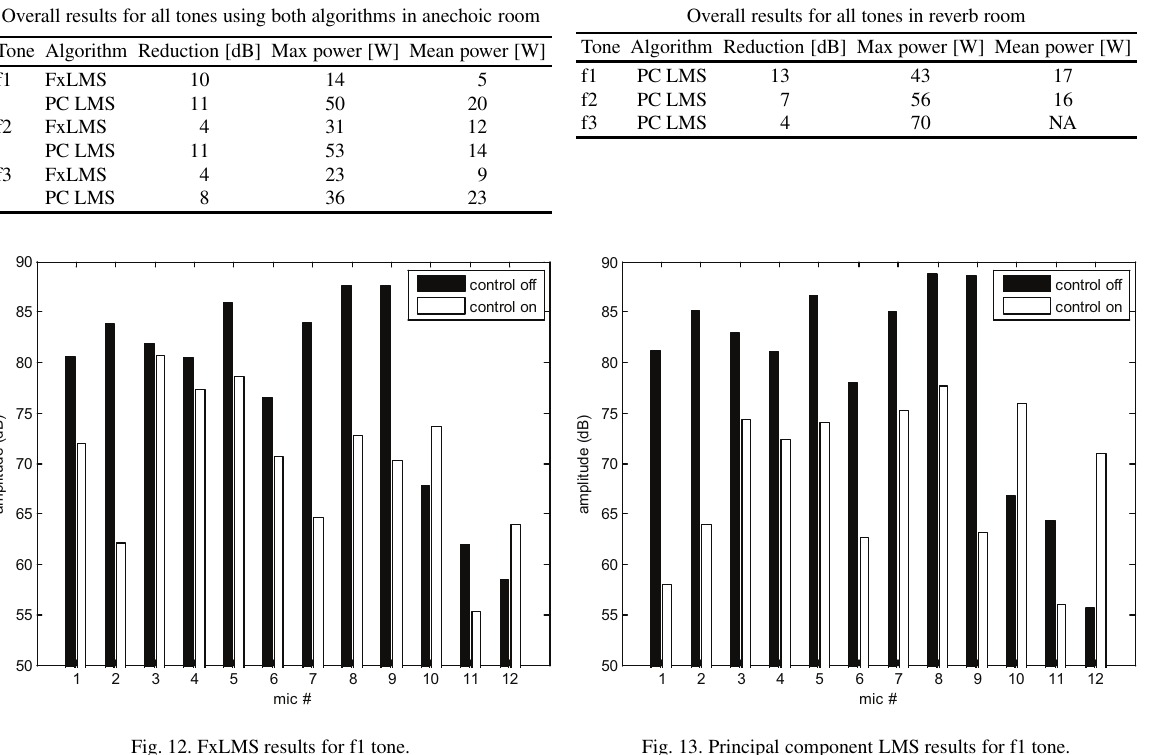
Fig. 12. FxLMS results for f1 tone. Fig. 13. Principal component LMS results for f1 tone.